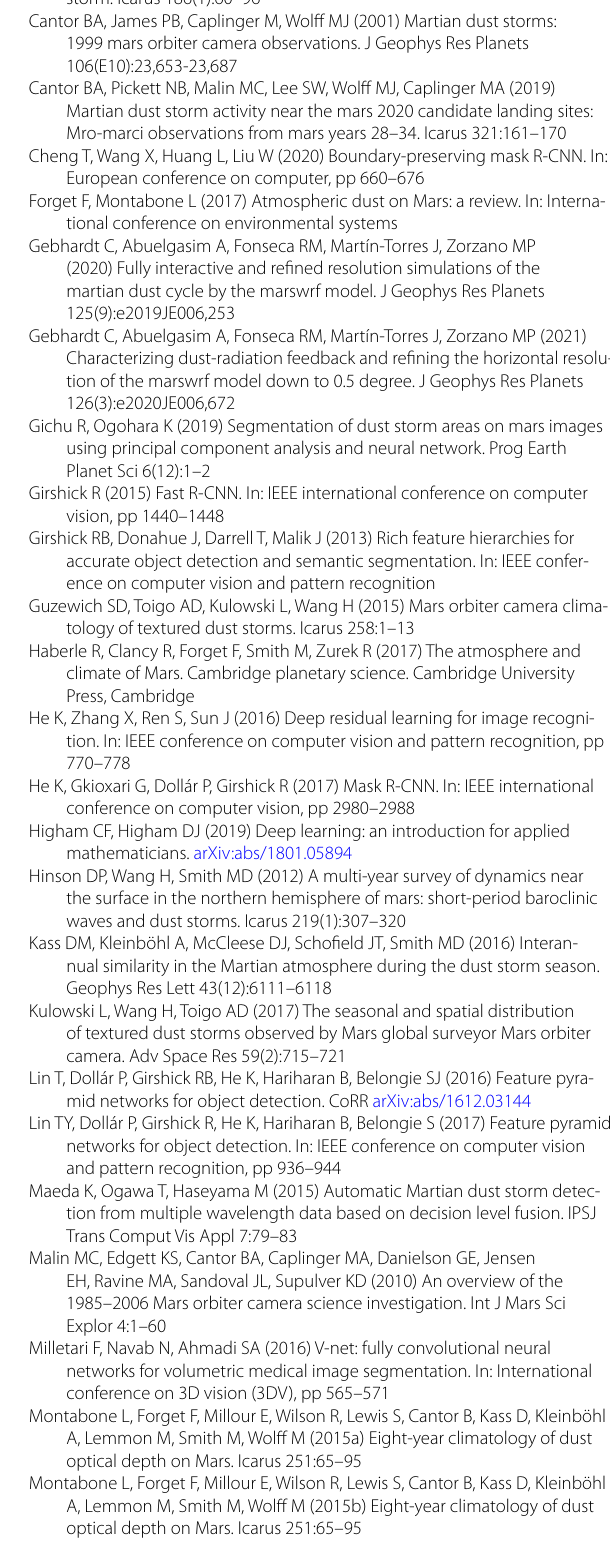
map using the aligning operation. It divides the input fea- ture map into spatial bins based on the ratio of the width of the input image to the width of the convolutional fea- ture map ( r = W / w ). Then, it uses bilinear interpolation to compute the exact values of the feature map at four regularly sampled locations in each bin, and produces an average or maximum value (He et al. 2017). For instance, Fig. 8c shows an example of the input feature map and RoI, presented in dashed grid and solid line squares. The RoI is within 2 × 2 bins with four sampling points in each. The RoIAlign computes the value of each point using bilinear interpolation of nearby grid points in the feature